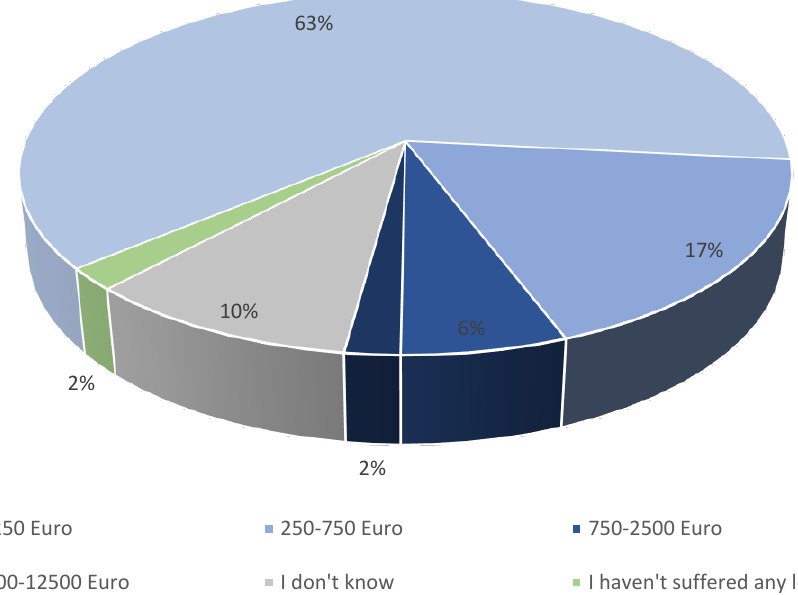
Figure 4. Losses incurred as a result of local flooding among the respondents declaring an occurrence of flooding ( n = 51). Source: own study based on questionnaire research.